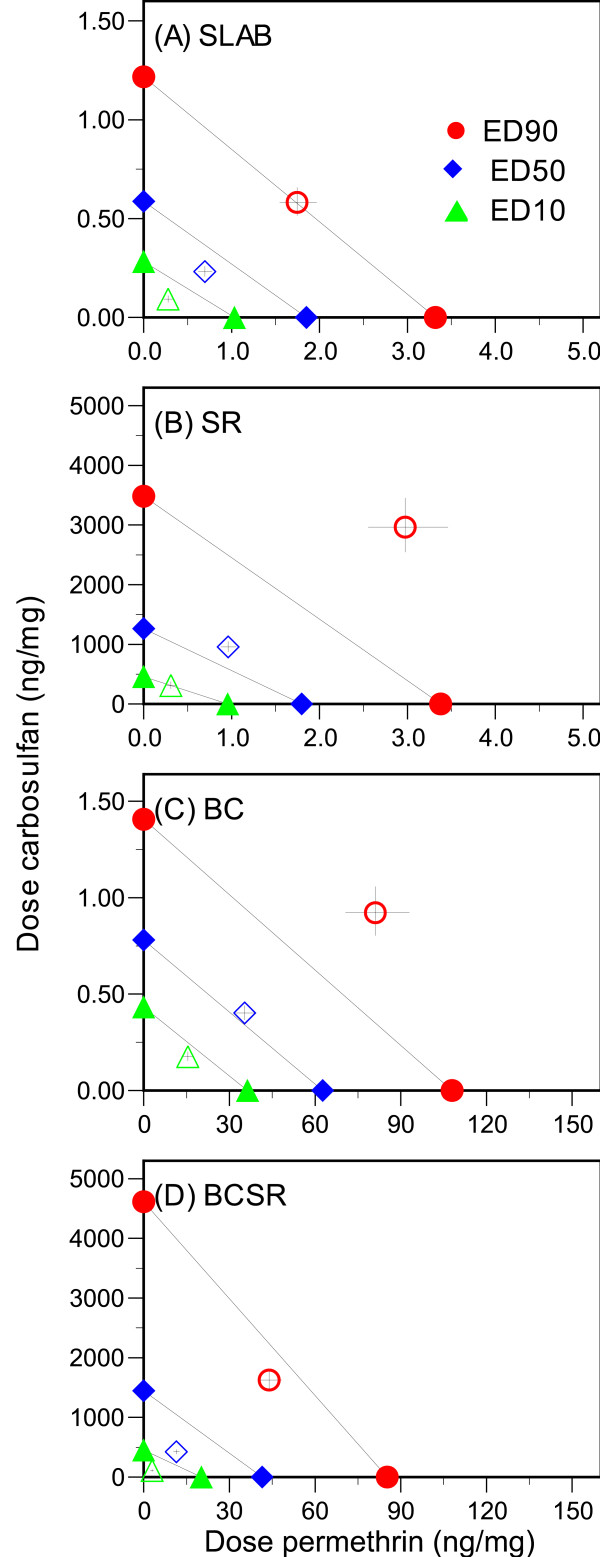
Isobolograms of insecticide activity. Diagonal lines connect doses of equally effective activity for each insecticide when applied alone. Open symbols are for the amount of each insecticide required for the same effect when the two are mixed together at a ratio based on their median-effect doses (± 95% confidence intervals). Points above the matching line indicate antagonistic activity of the insecticides, close to the line indicates additivity of action, and those below the line indicate synergistic activity.